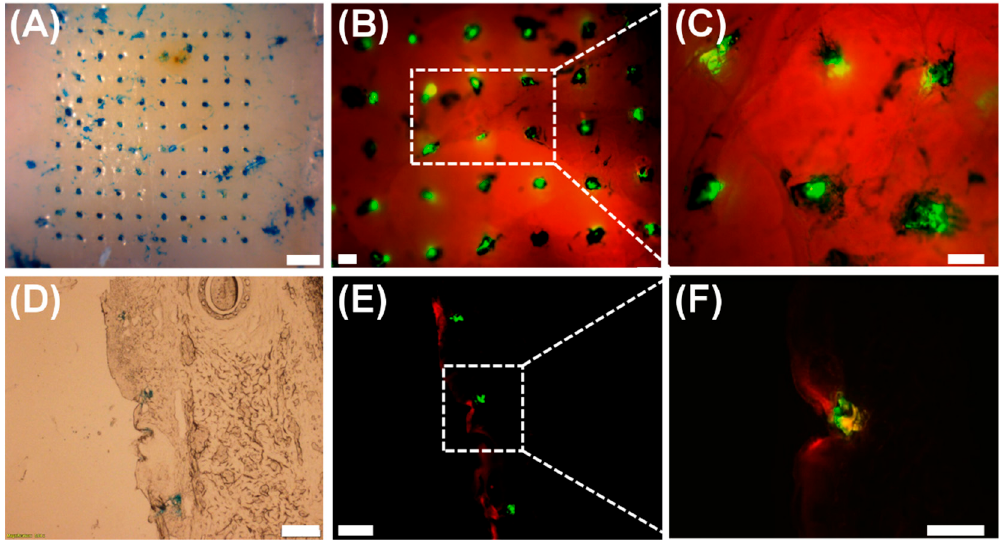
Figure 5. Representative images of pig cadaver skin after insertion tests. ( A ) Top view of the skin showing insertion sites. ( B ) and ( C ) Corresponding fluorescence images of the skin. ( D ) Cross-section of the skin. ( E ) and ( F ) Corresponding fluorescence images showing the dyes released in the skin at different rates. Scale bars represent 1 mm in (A) and 200 µm in (B–F).